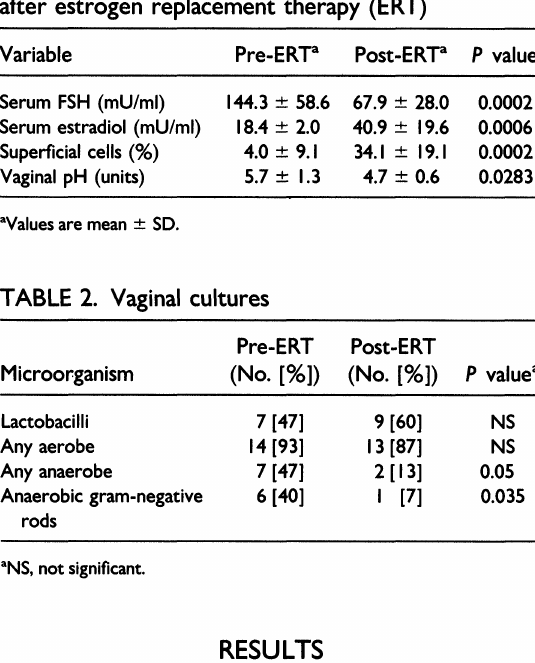
TABLE I. Population characteristics before